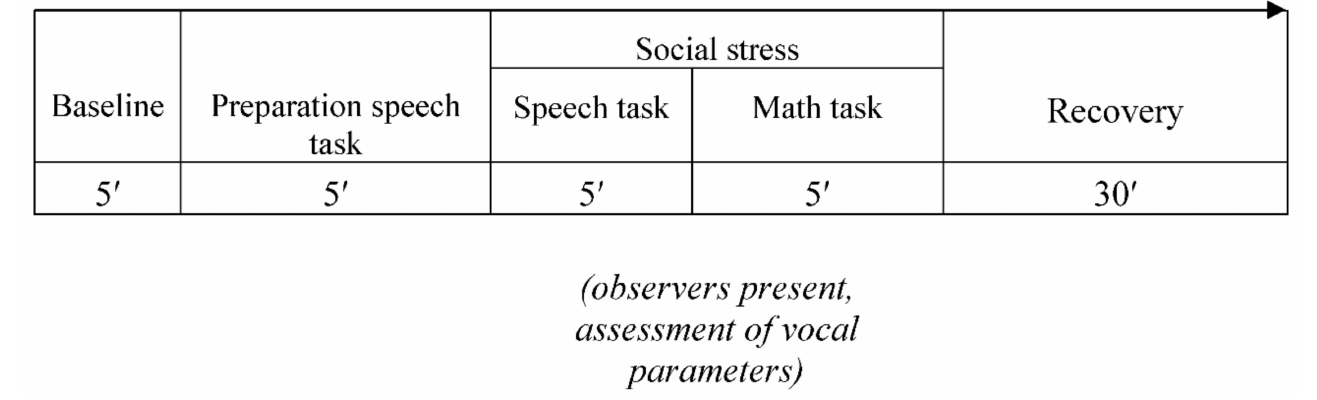
Figure 2. Overall procedure including the Trier Social Stress Test for Children depicted in minutes (TSST-C). The same procedure was followed before and after treatment or